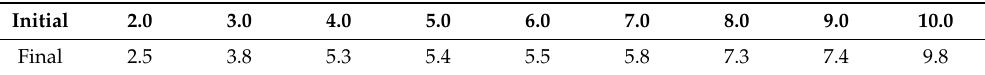
Table 4. Initial and final pH of adsorbate for YTBS sorption of Cd(II).